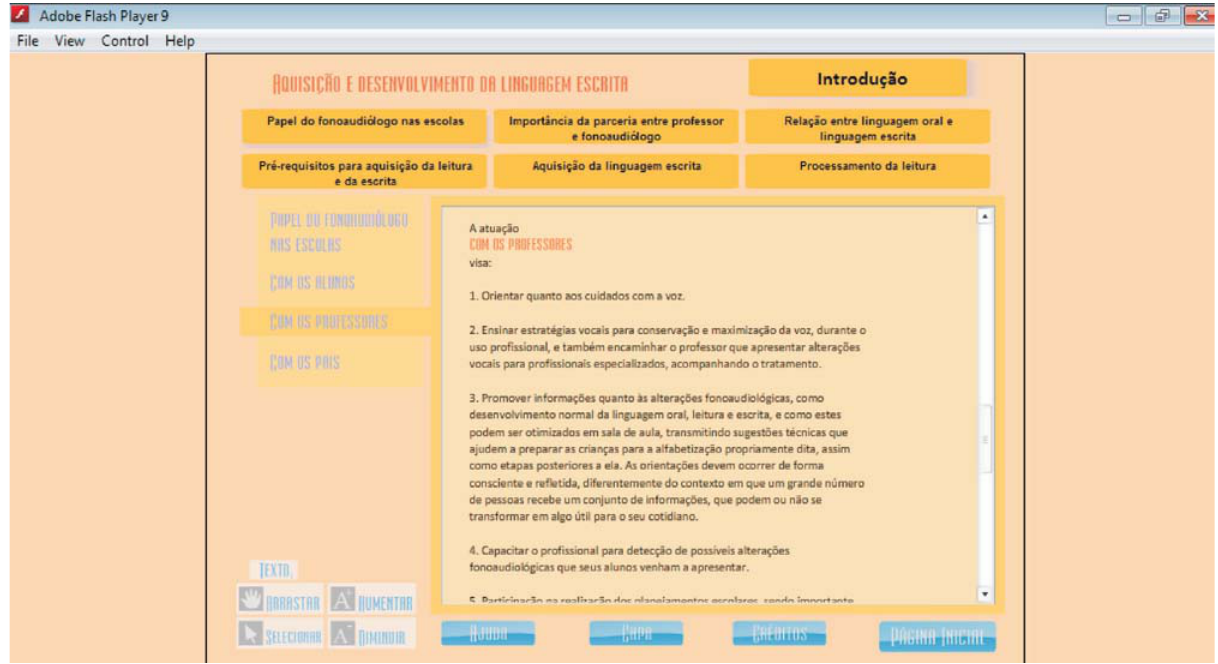
Figure 1- Content involving the speech therapist’s role in